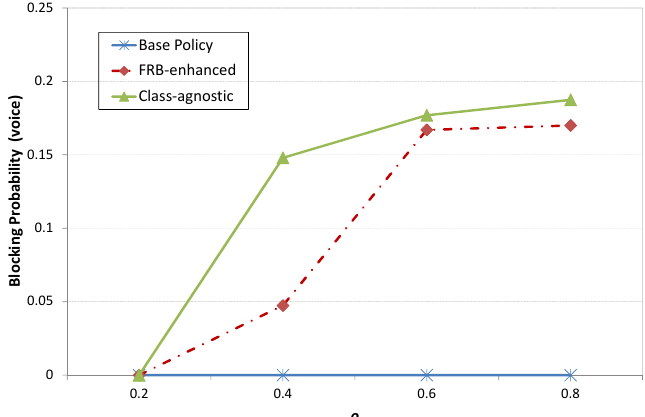
Figure 14. Class 1 (voice) services blocking probabilities for the three